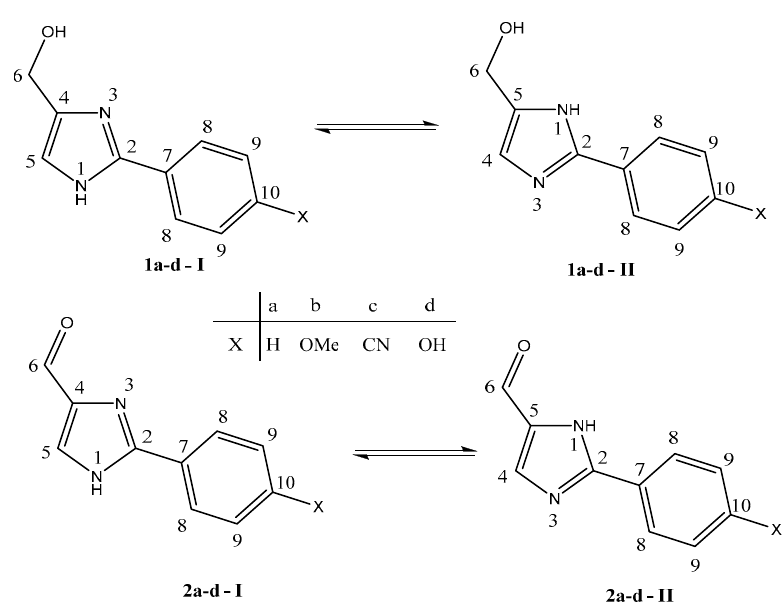
Figure 1. Molecular structures of the studied 2-phenyl substituted imidazoles: 1a – d— (2-phenyl- 1 H -imidazol-4(5)-yl)methanols and 2a – d— 2-phenyl-1 H -imidazole-4(5)-carbaldehydes. Both tautomeric forms ( I and II ) are depicted along with the atoms numbering used in the chemical shift assignments of the NMR signals. (Although the numbering is not fully in line with IUPAC guidelines, it is used here for convenience).